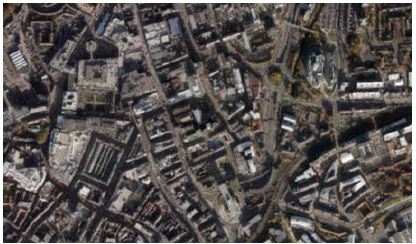
Figure 1. Orthophoto showing the city centre of Newcastle upon Tyne at 1:4500 ©UltraMap XP Image Copyright 2010, Ordnance Survey